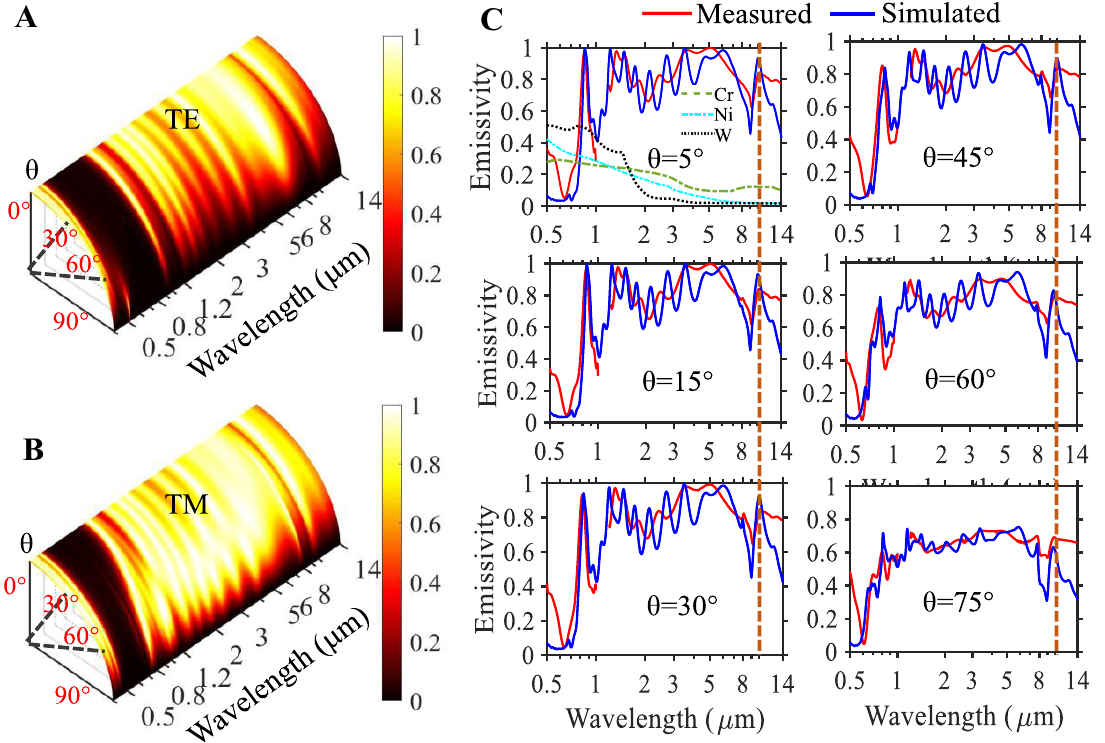
Figure 2: The spectral characteristics of the LTEs at different angle and polarization.